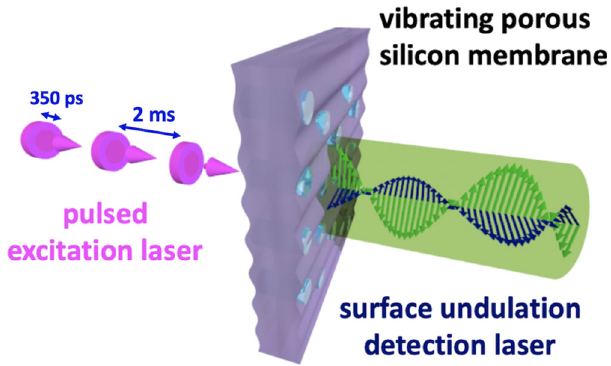
Fig. 1 Laser ultrasonics experiment. Laser-induced thermoelastic excitation of elastic guided waves in a nanoporous silicon membrane along with laser- interferometrical detection of the resulting undulations dynamics at the membrane surface. Shown is a symmetric elastic guided